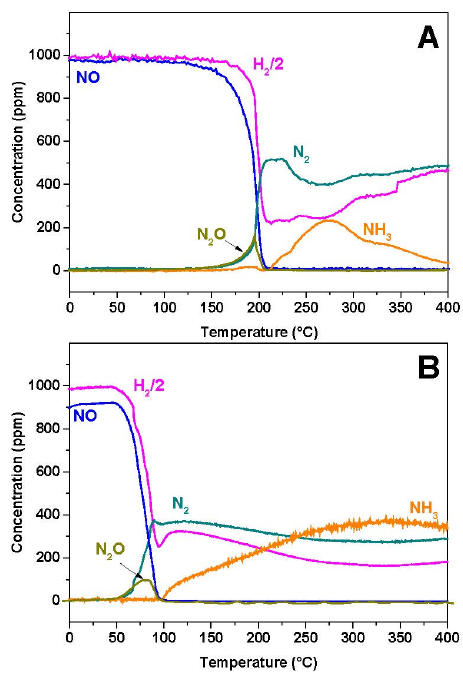
Figure 3. NO/H 2 ‐ TPR experiments with NO (1000 ppm) + H 2 (2000 ppm) over ( A ) Rh ‐ BaO/Al 2 O 3 and Figure 3. NO/H 2 -TPR experiments with NO (1000 ppm) + H 2 (2000 ppm) over ( A ) Rh-BaO/Al 2 O 3 ( B ) Pt ‐ BaO/Al 2 O 3 from 40–400 °C (4 °C/min), (rig#3). and ( B ) Pt-BaO/Al 2 O 3 from 40–400 ˝ C (4 ˝ C/min), (rig#3).